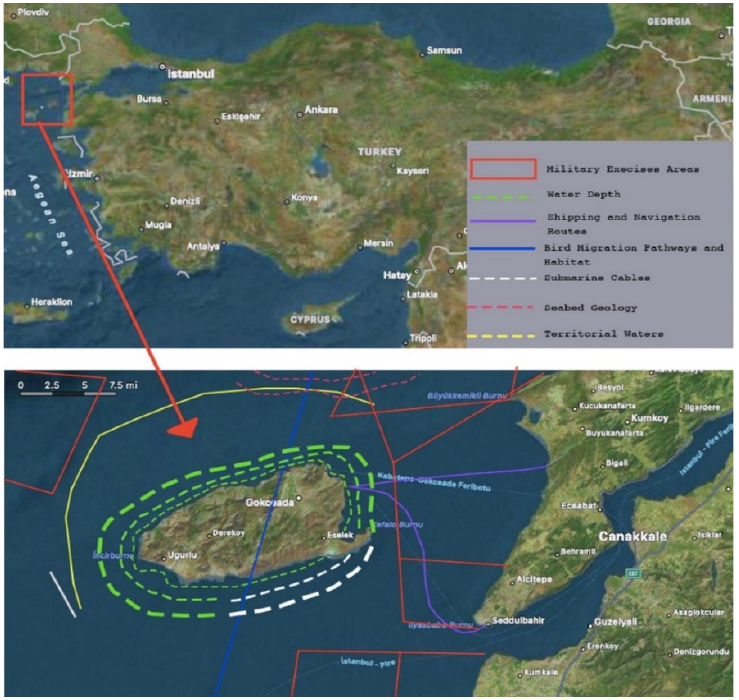
Figure 1. Gokceada Island location and usage map [30].